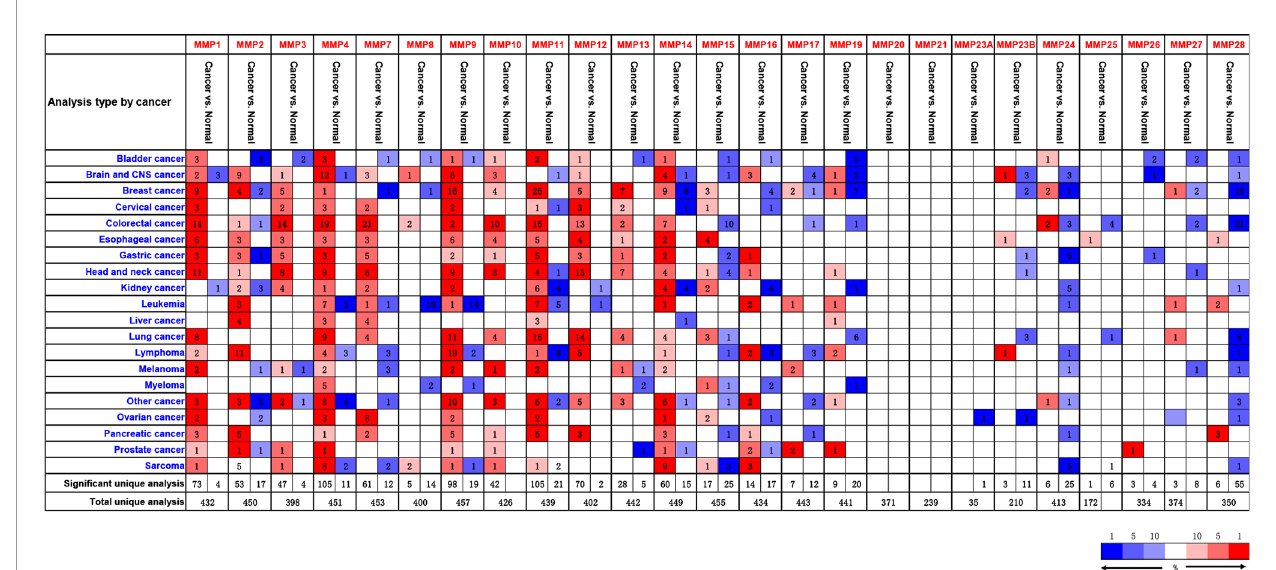
FIGURE 1 | The transcription levels of MMPs in different types of cancers (Oncomine). Upregulated records are highlighted in red, while downregulated records are highlighted in blue. The number in each block means the number of unique analyses, which were fully described in Supplementary Tables S4 , S5